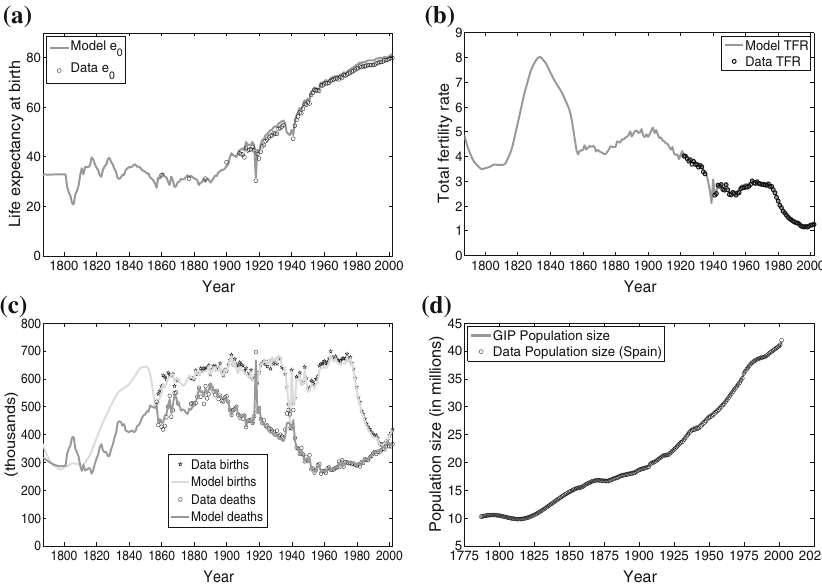
Fig.9 In-sampleperformanceoftheGIPmodeltoexistingdemographicdata.Spain:Selectedyearbetween 1787and2000. a Lifeexpectancyatbirth, b totalfertilityrates, c totalbirthsanddeathsand d